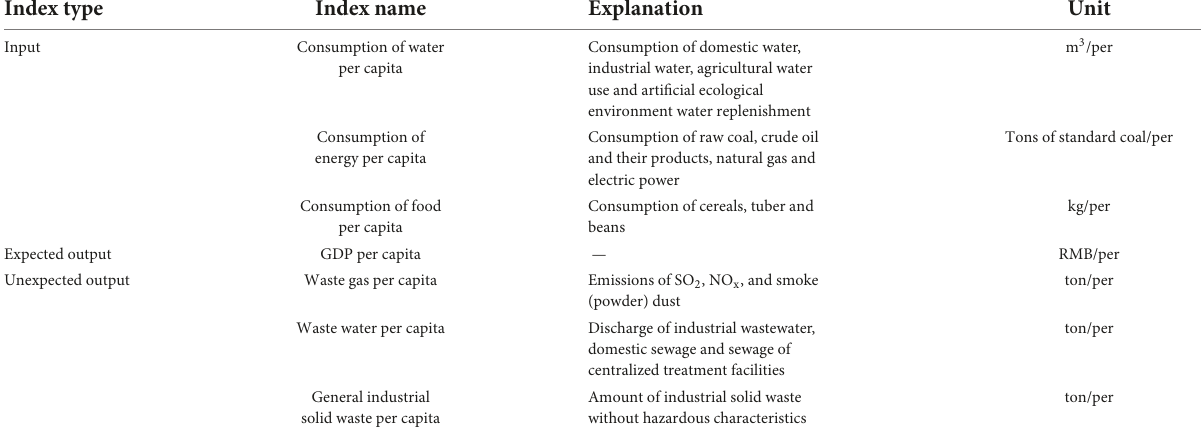
TABLE 1 Index system of input–output.